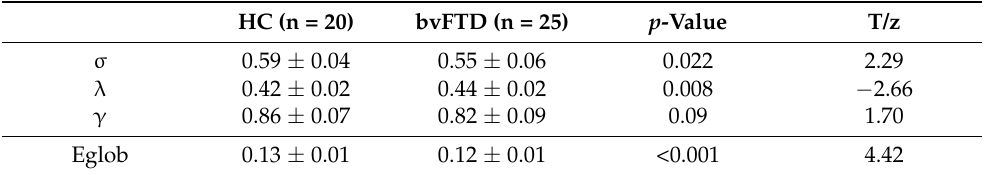
Table 2. Main effect of the group in the global network